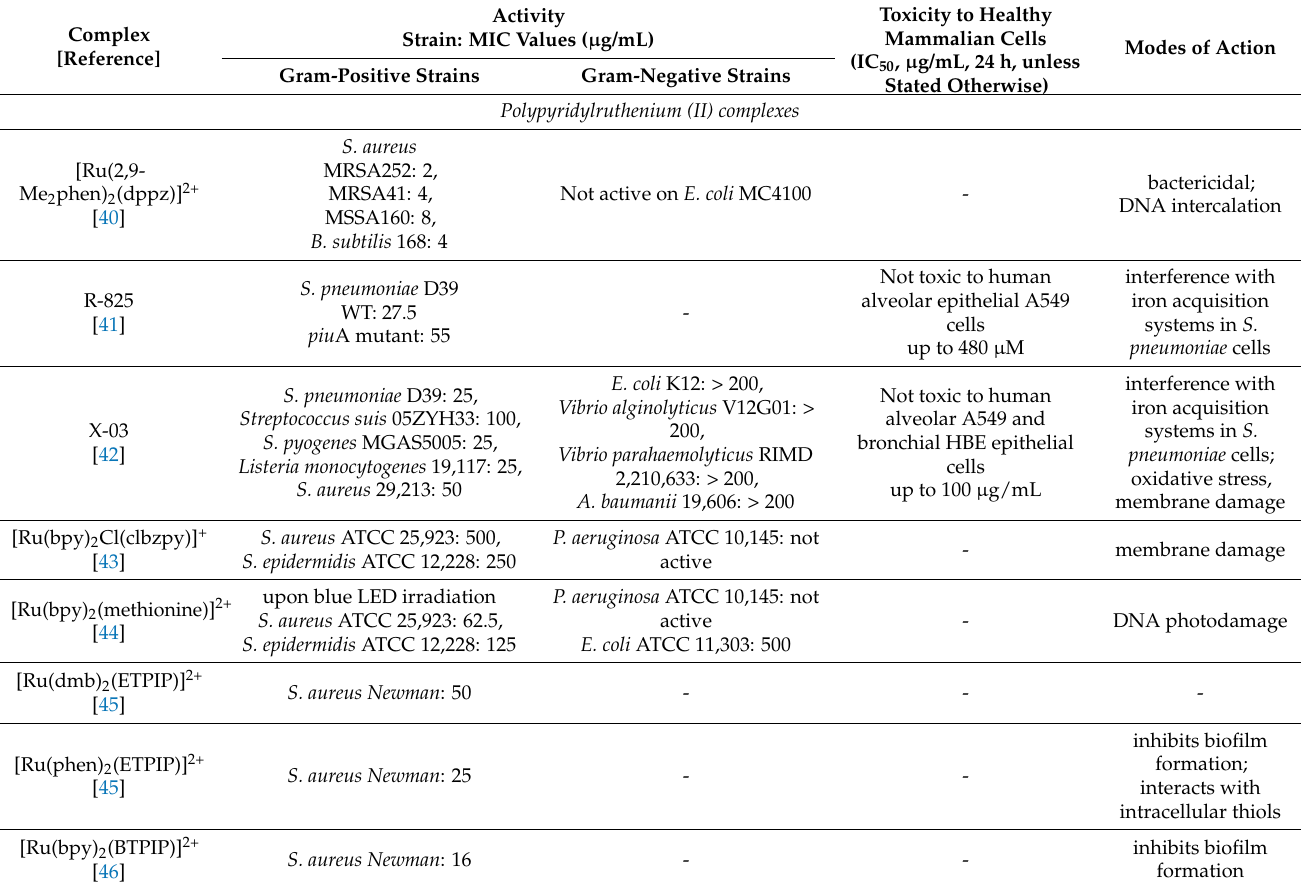
Figure 3. Examples of inert structural mononuclear polypyridylruthenium (II) complexes. Following up on this remarkable work, various heteroleptic mononuclear polypyridyl Ru (II) complexes were tested for antibacterial activity. Their activities (MIC values) against various bacterial strains, as well as toxicity towards healthy eukaryotic cells and modes of action, where available, are listed in Table 1. Table 1. Activities of selected ruthenium complexes against bacteria, toxicity to healthy mammalian cells, and mode of